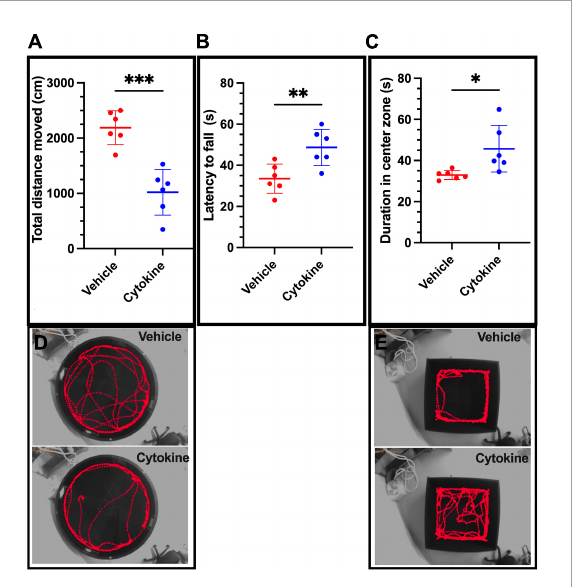
FIGURE2 Cytokine (GM-CSF and IL-3) treatment significantly ameliorates neurological functional deficits in ischemic brain rats at 30 dpr. (A) Cytokine administration ameliorates spatial cognitive dysfunction, as shown by the Morris Water Maze test. (B) Cytokines improve motor deficits as assessed by the rota-rod test. (C) On the open-field test, the cytokine-treated group spends more time in the center zone. (D) Representative swim traces in Morris Water Maze test. (E) Representative travel route maps in the open-field test for the two groups. Data are shown as means ± SD and were statistically analyzed with Student’s t- test ( n = 6). ∗ P < 0.05, ∗∗ P < 0.01, ∗∗∗ P < 0.001 vs. vehicle